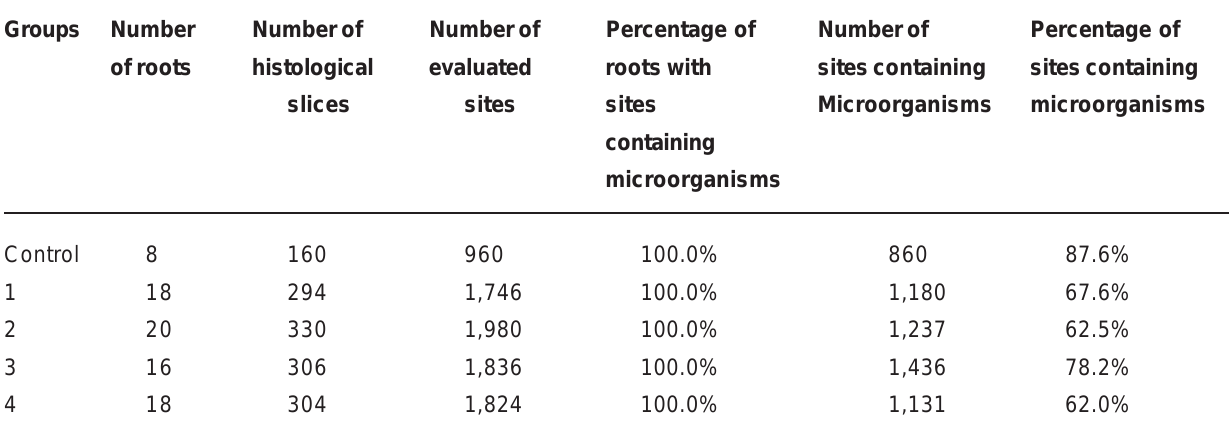
TABLE 2- Relative and absolute frequencies of sites containing microorganisms in histomicrobiological